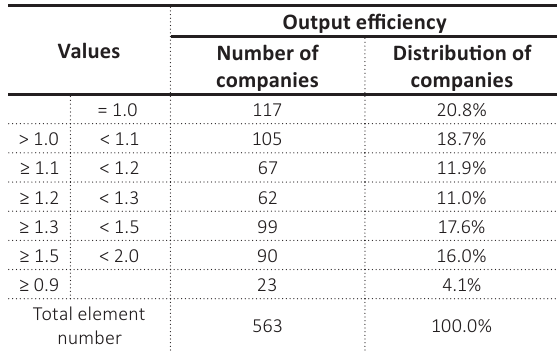
Table 4. Empirical distribution of output efficiency values based on the average of the years